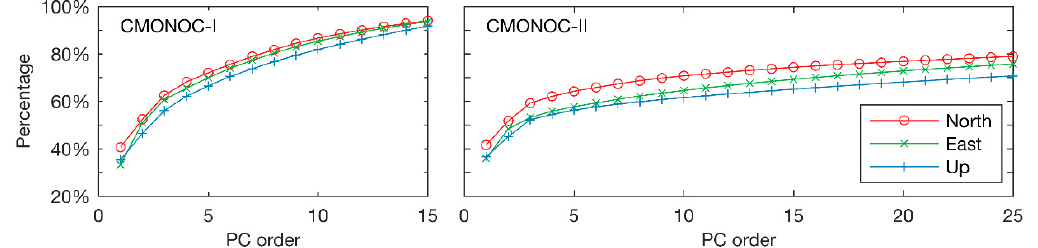
Figure 2. Cumulative percentage of the first 15 CMONOC-IPC eigenvalues ( left panel ) and the first 25 CMONOC-II PC eigenvalues ( right panel ).